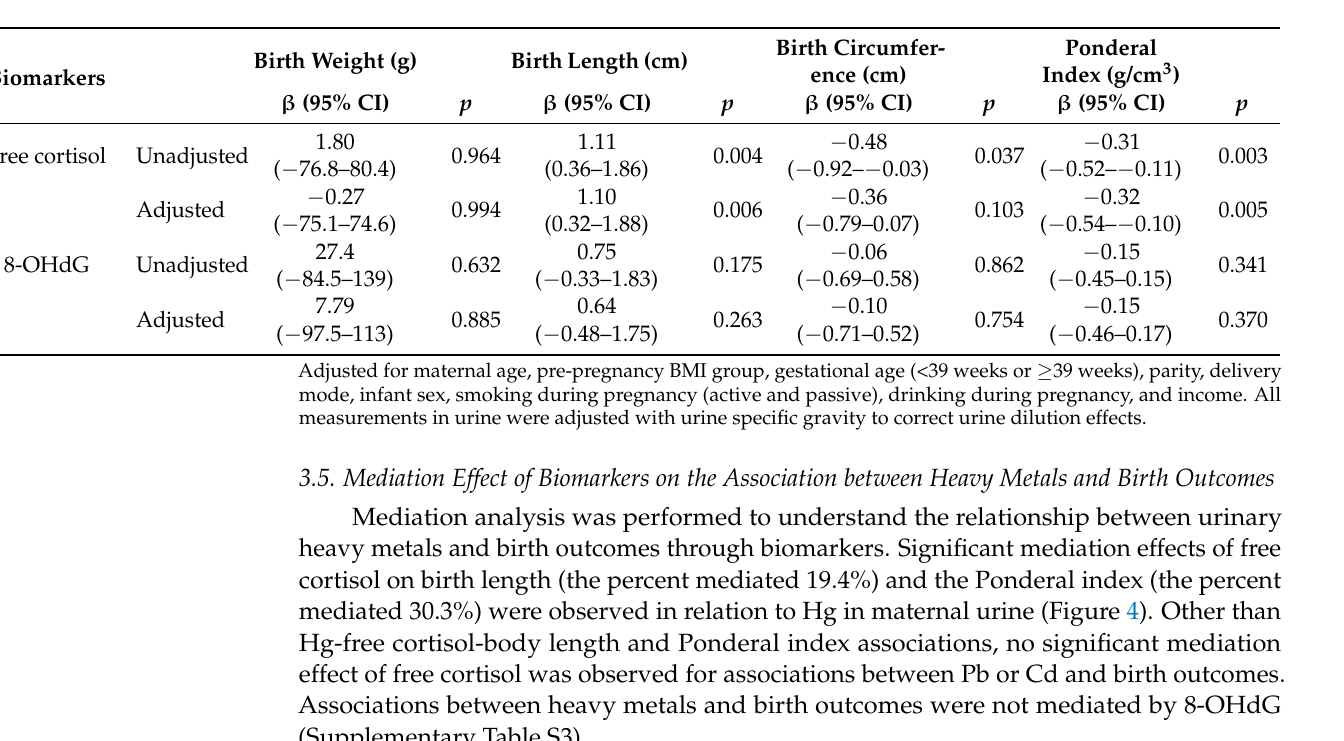
Table 3. Multiple linear regression coefficients (95% CI) between biomarkers and neonatal anthropo- metric measures.